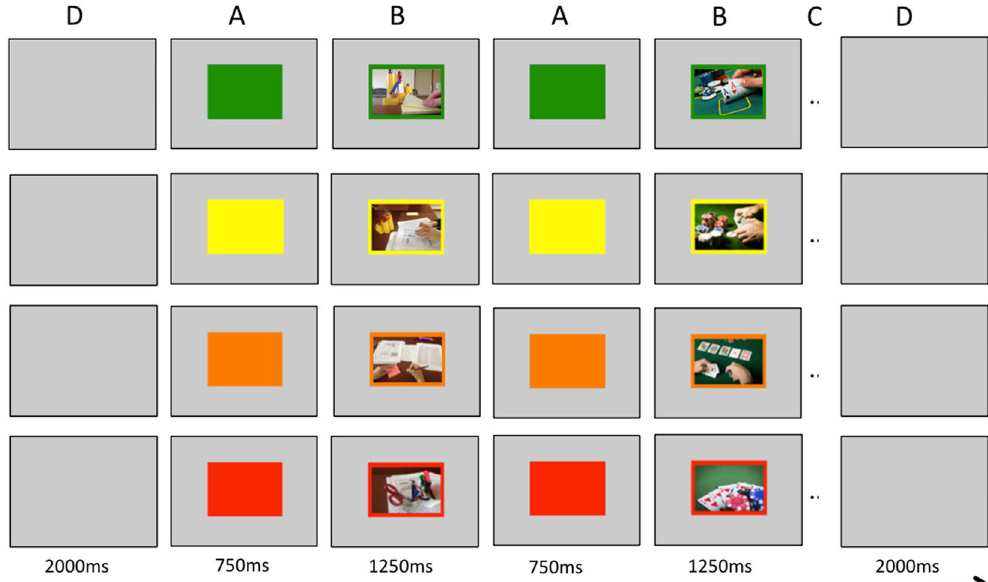
Figure 4. An example of a succession between a neutral and a poker pictures in the green, yellow, orange and red contexts of the stop-signal task. ( A ) Each trial started with the presentation of the context cue for 750 ms. ( B ) A picture then appeared during 1250 ms, regardless of participants’ categorization reaction time. ( C ) Trials were divided into runs of 9, 18 or 27 trials in a same context. ( D ) A context change was indicated by a 2000 ms grey